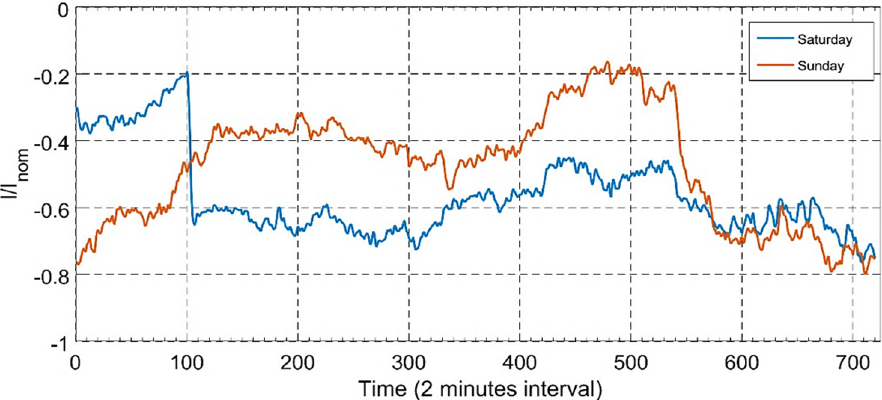
Figure 23. Evolution of the load factor for different working days (2nd to 6th) of the first week of February.